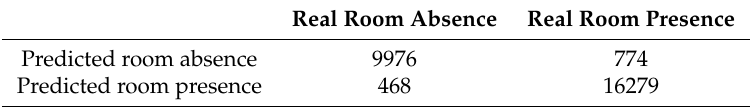
Table 8. Contingency table for the “transferred” normalised